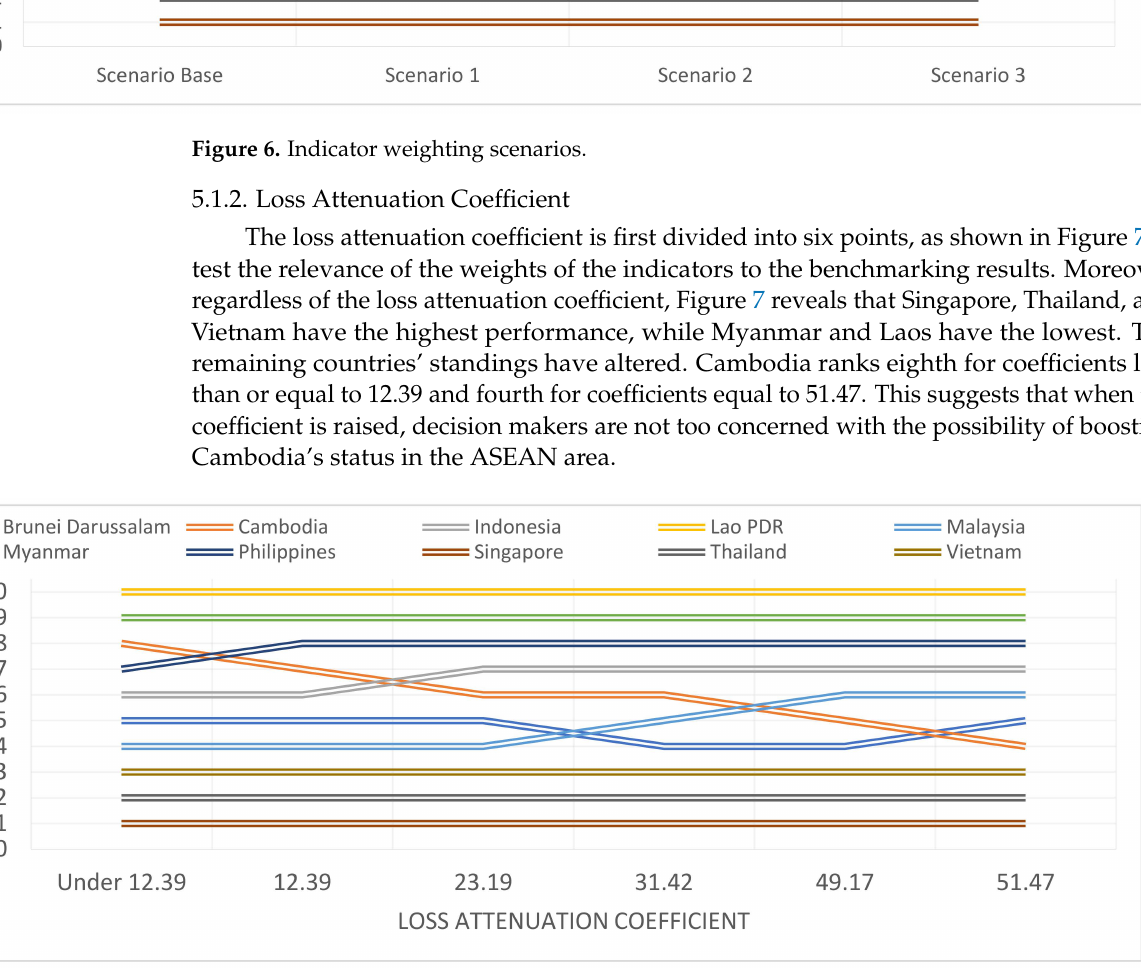
Figure 7. Sensitivity analysis results of loss attenuation